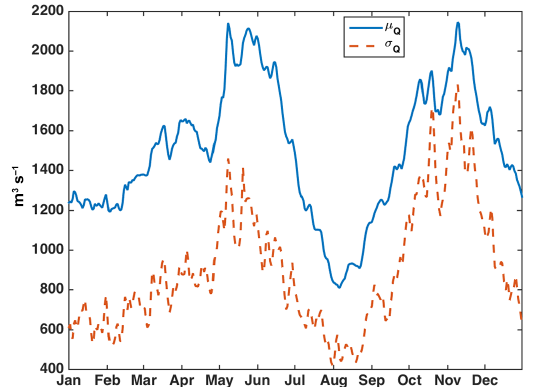
Figure 2. Daily mean value µ Q (m 3 s − 1 ) and daily standard de- viation σ Q (m 3 s − 1 ) of the daily flows in the observation period (1920–2009) at